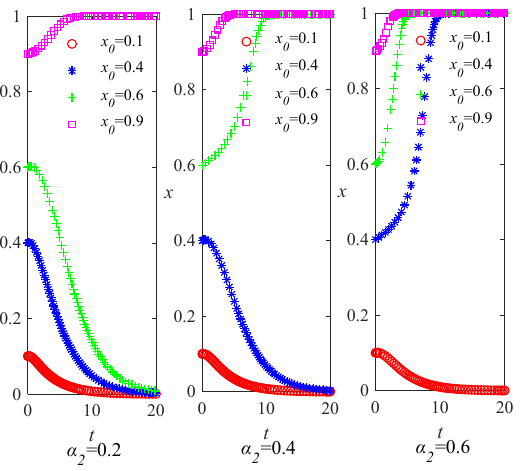
Figure 11. The impact of government subsidy to recycling enterprises on system evolution results.